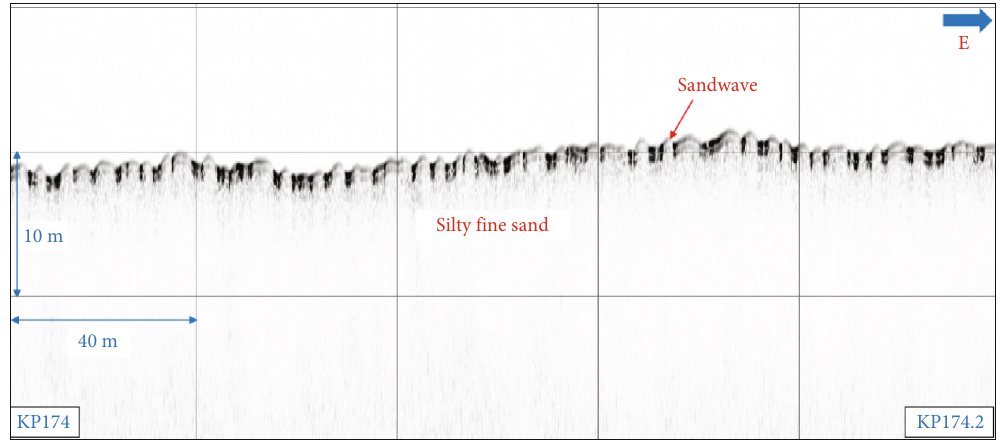
Figure 14: Shallow stratigraphic images at the top of the sand ridge in a typical erosion depression geomorphic area.